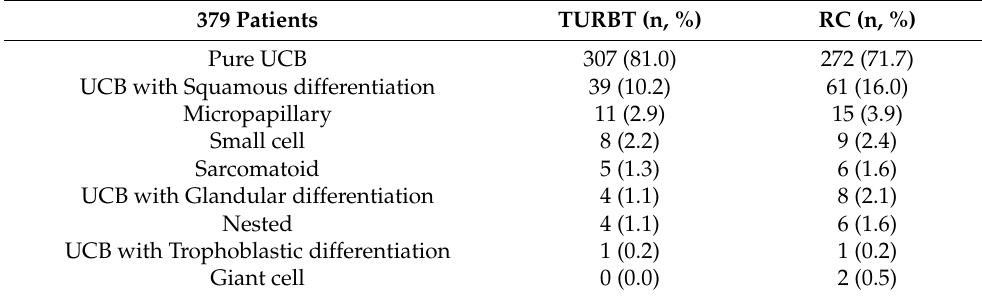
Table 2. Presence of BHV at pathologic examination in transurethral resection and subsequent radical cystectomy. WHO 2004 (third edition) classification for tumours of the urothelial